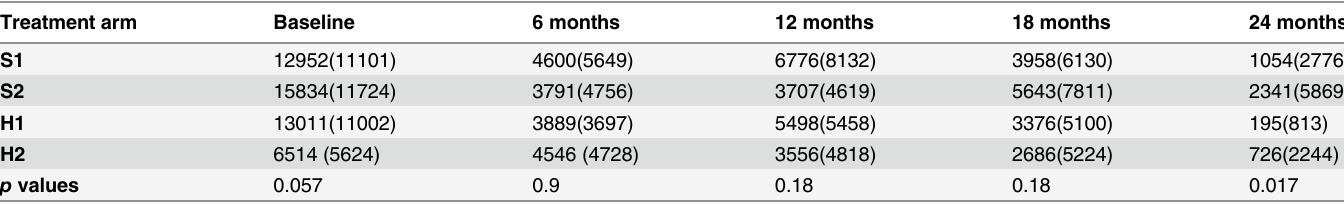
Table 8. Changes in antigenemia (OG 4 C 3 ) over period in the four arms: Mean (SD) of (OG 4 C 3 ) units for treatment arms over 24 months. Treatment arm